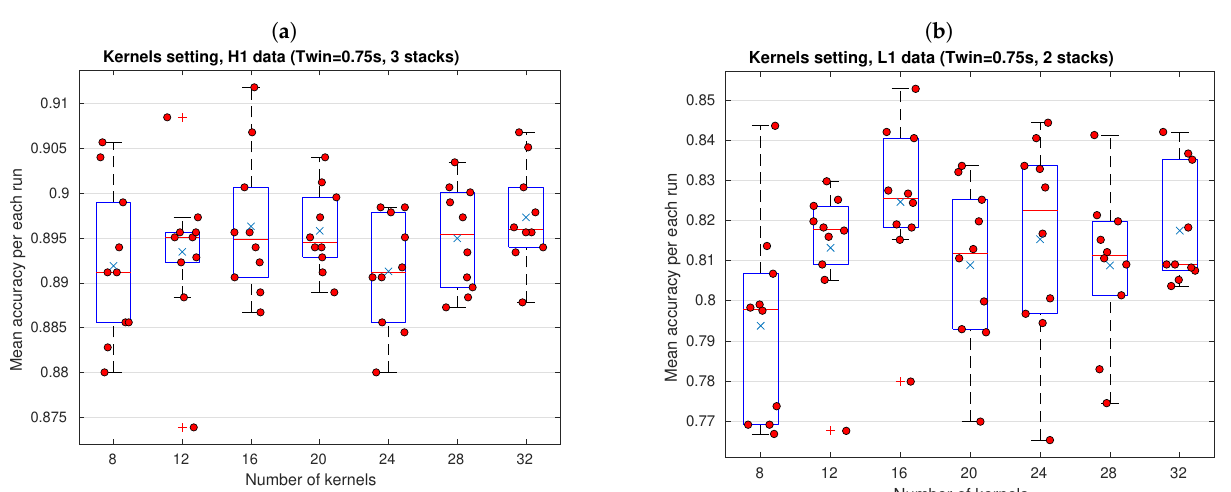
Figure 8. Adjustment to find the optimal number of kernels in CNNs for H1 data ( a ) and L1 data ( b ). Both panels show boxplots for the distributions of mean accuracies in function of the number of kernels, with values of T win and mount of stacks found in previous hyperparameter adjustments. Based on location of mean accuracy samples, dispersion, presence of outliers, and skewness of distributions, CNN architectures with 32 kernels and 16 kernels are the optimal choices to reach the highest mean accuracy values, when working with data from the H1 and L1 detectors,